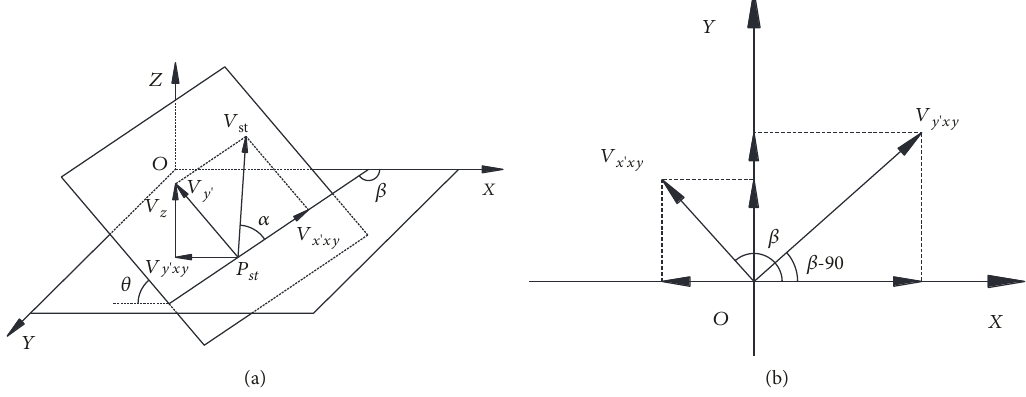
Figure 5: Decomposition of the three-dimensional velocity